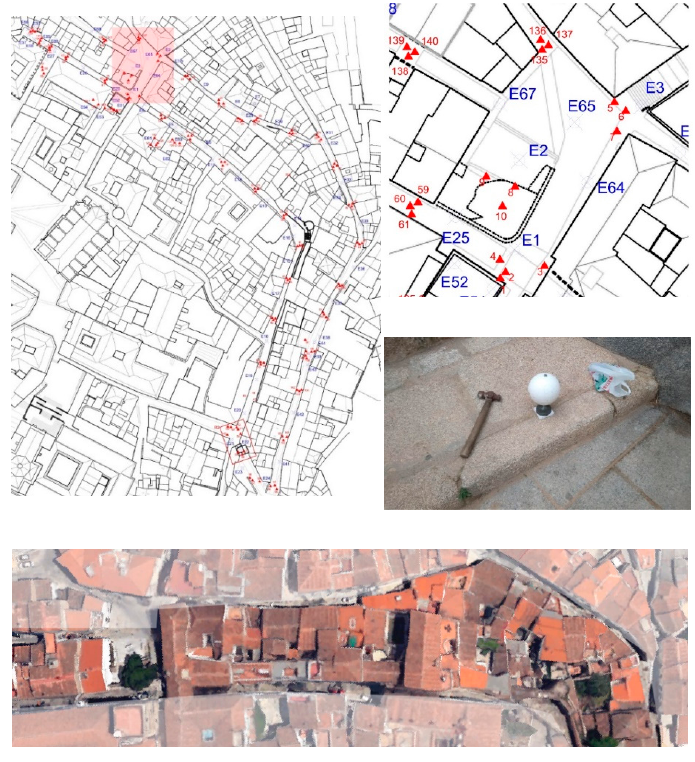
Figure 7. Location and detail of the spheres along a segment of the studied area.